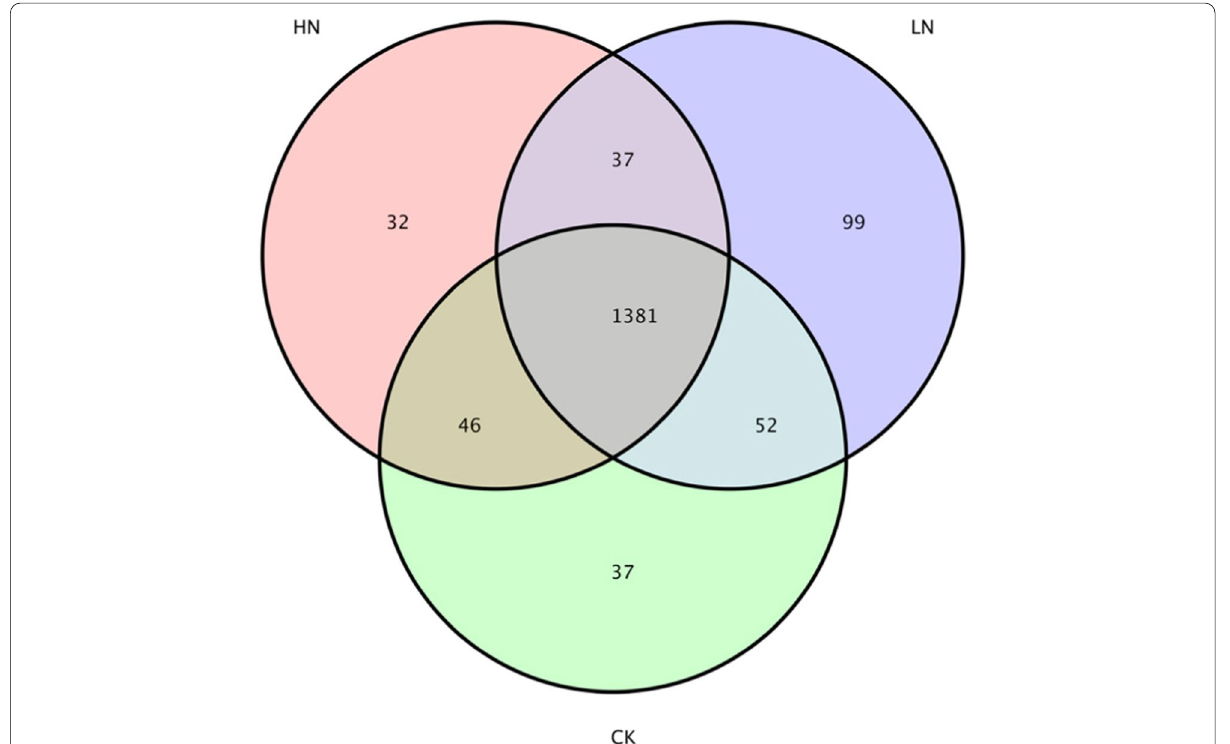
Fig. 4 Venn analysis of soil bacteria communities under different nitrogen deposition treatments based on OTU